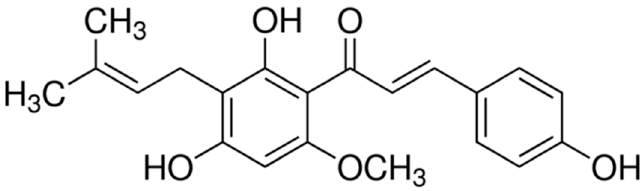
Figure 1. Structure of xanthohumol.